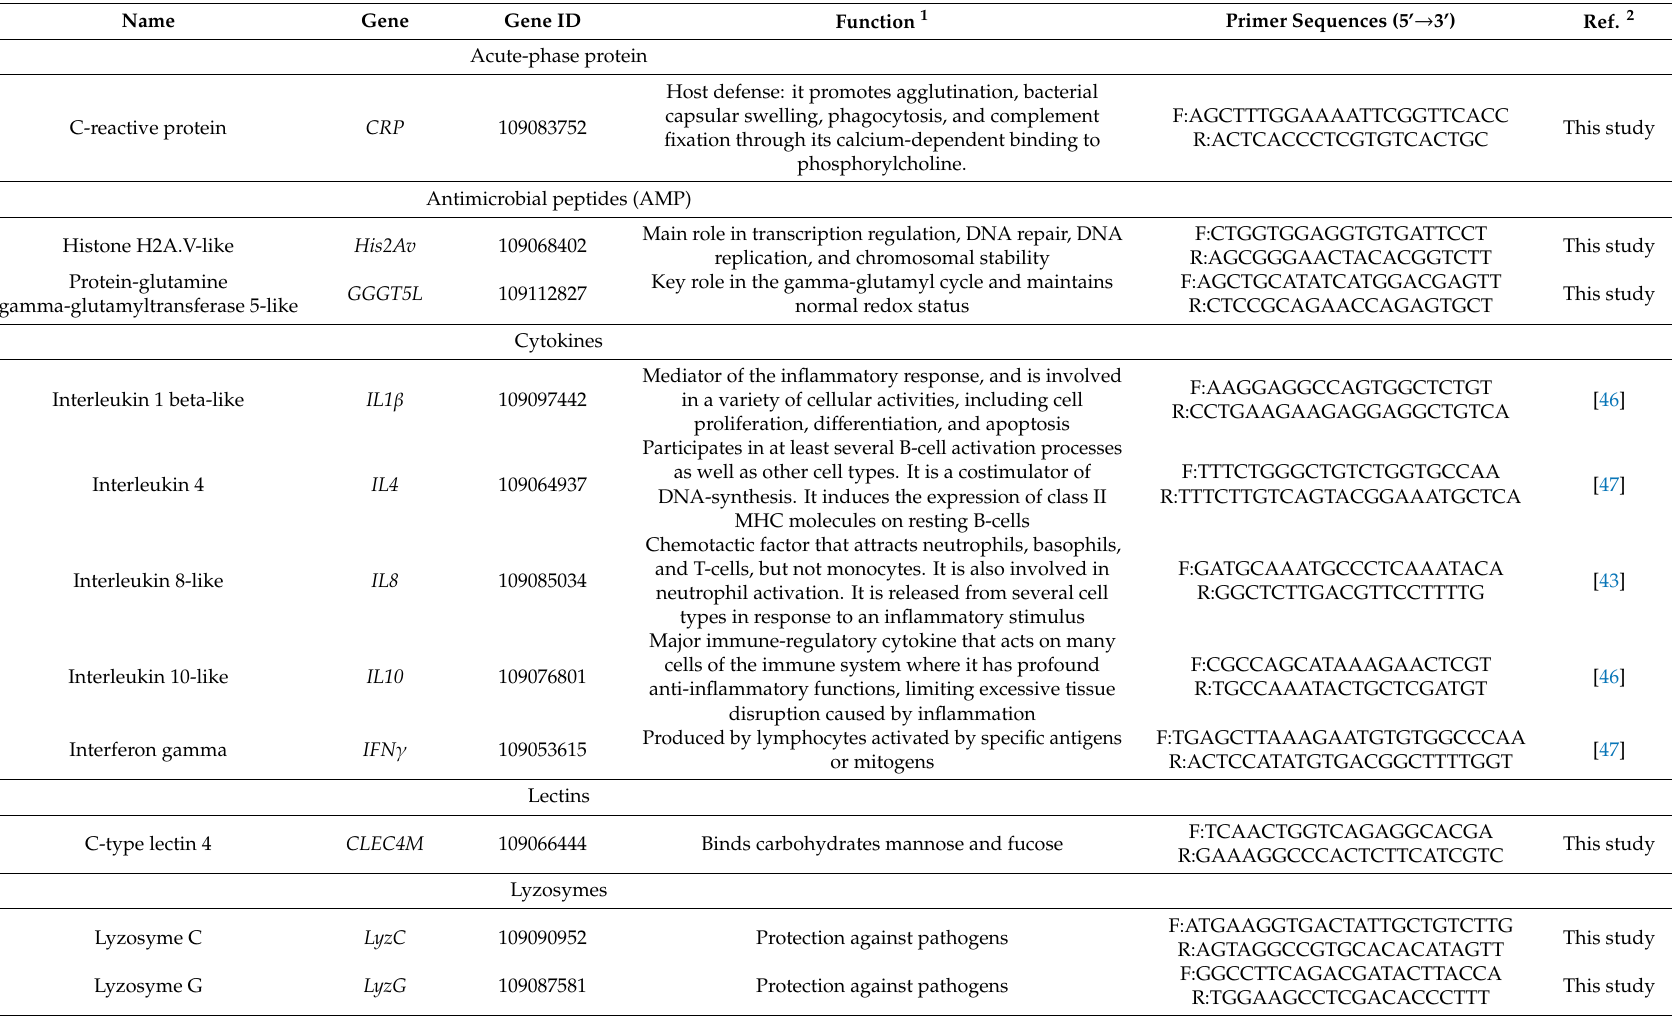
Table 3. Immune-related genes and primer sequences for RT-qPCR analysis of the skin mucosa in common